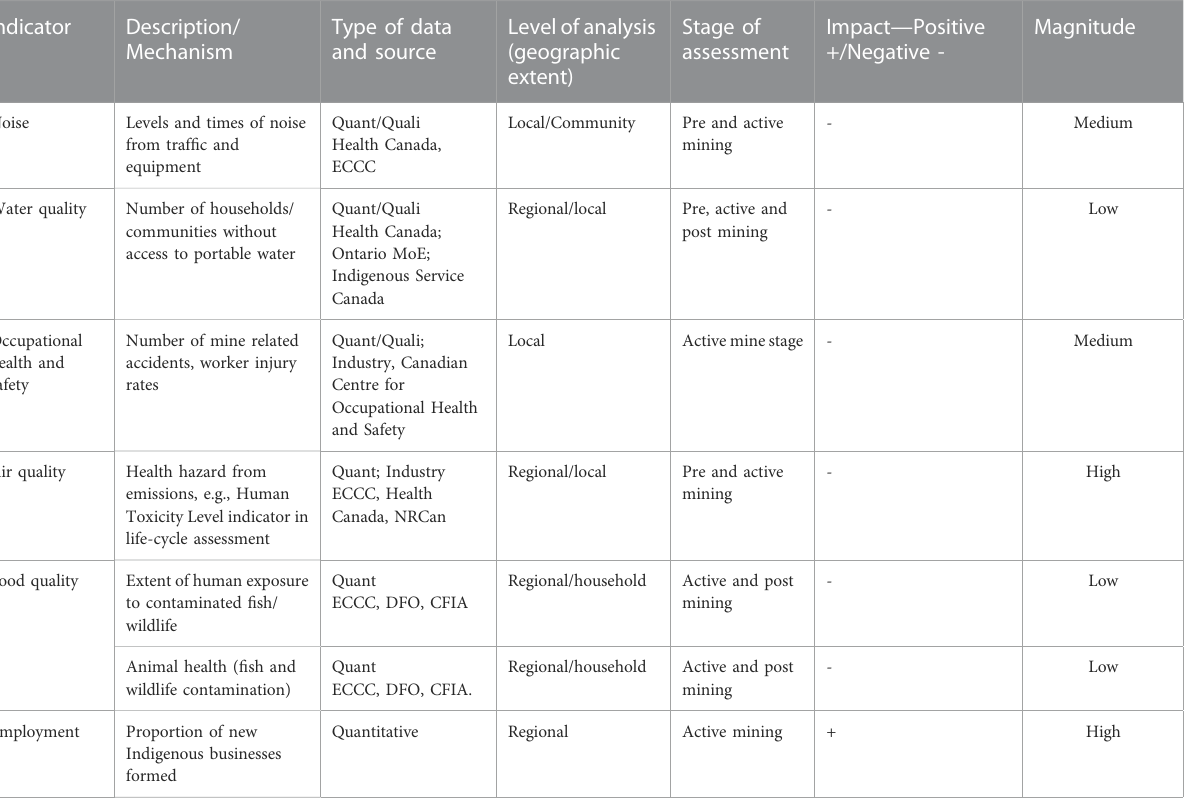
TABLE 7 Data types, sources and analysis for indicators derived from BRAT